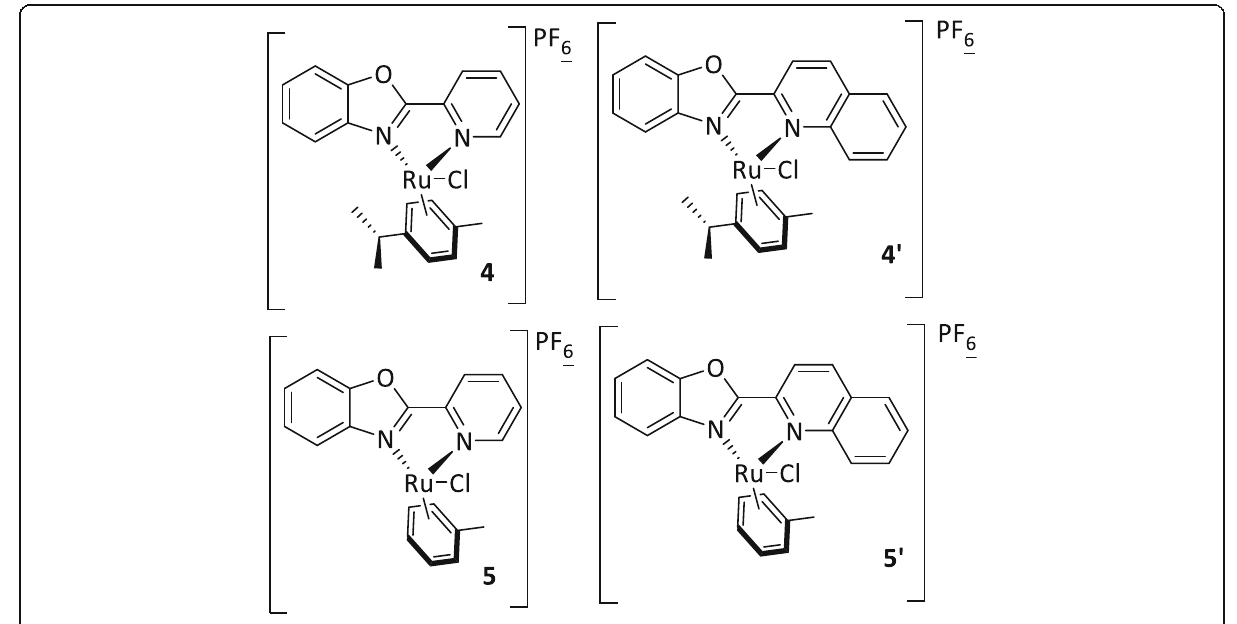
Fig. 42 Ru(II)-arene-2-pyridinylbenzoxazole